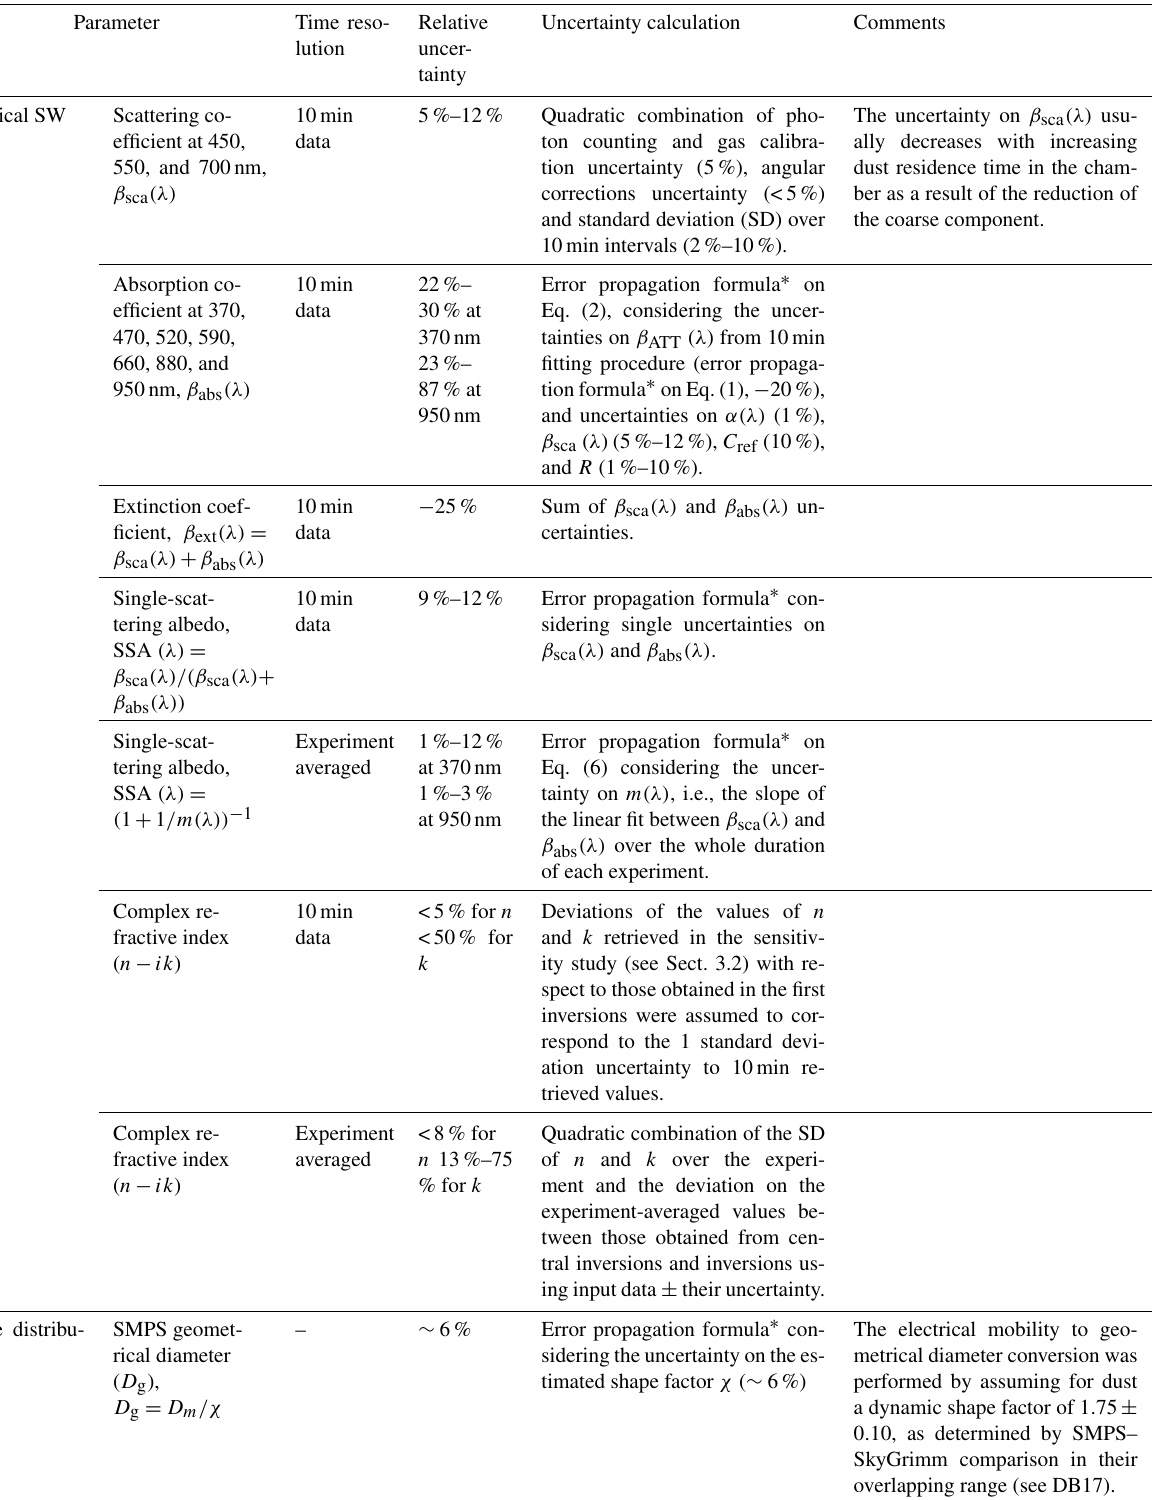
Table 1. Measured and retrieved quantities and their estimated relative uncertainties. For further details, refer to Sect. 2, as well DB17 and